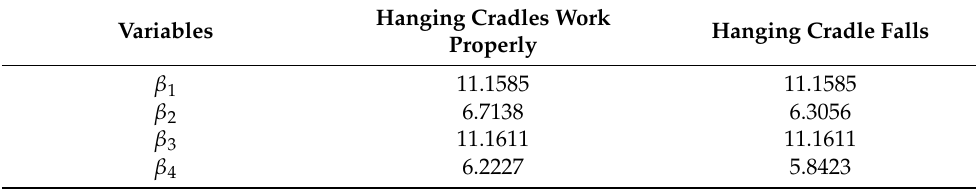
Table 8. Influence of the working condition of the hanging cradle on the reliability